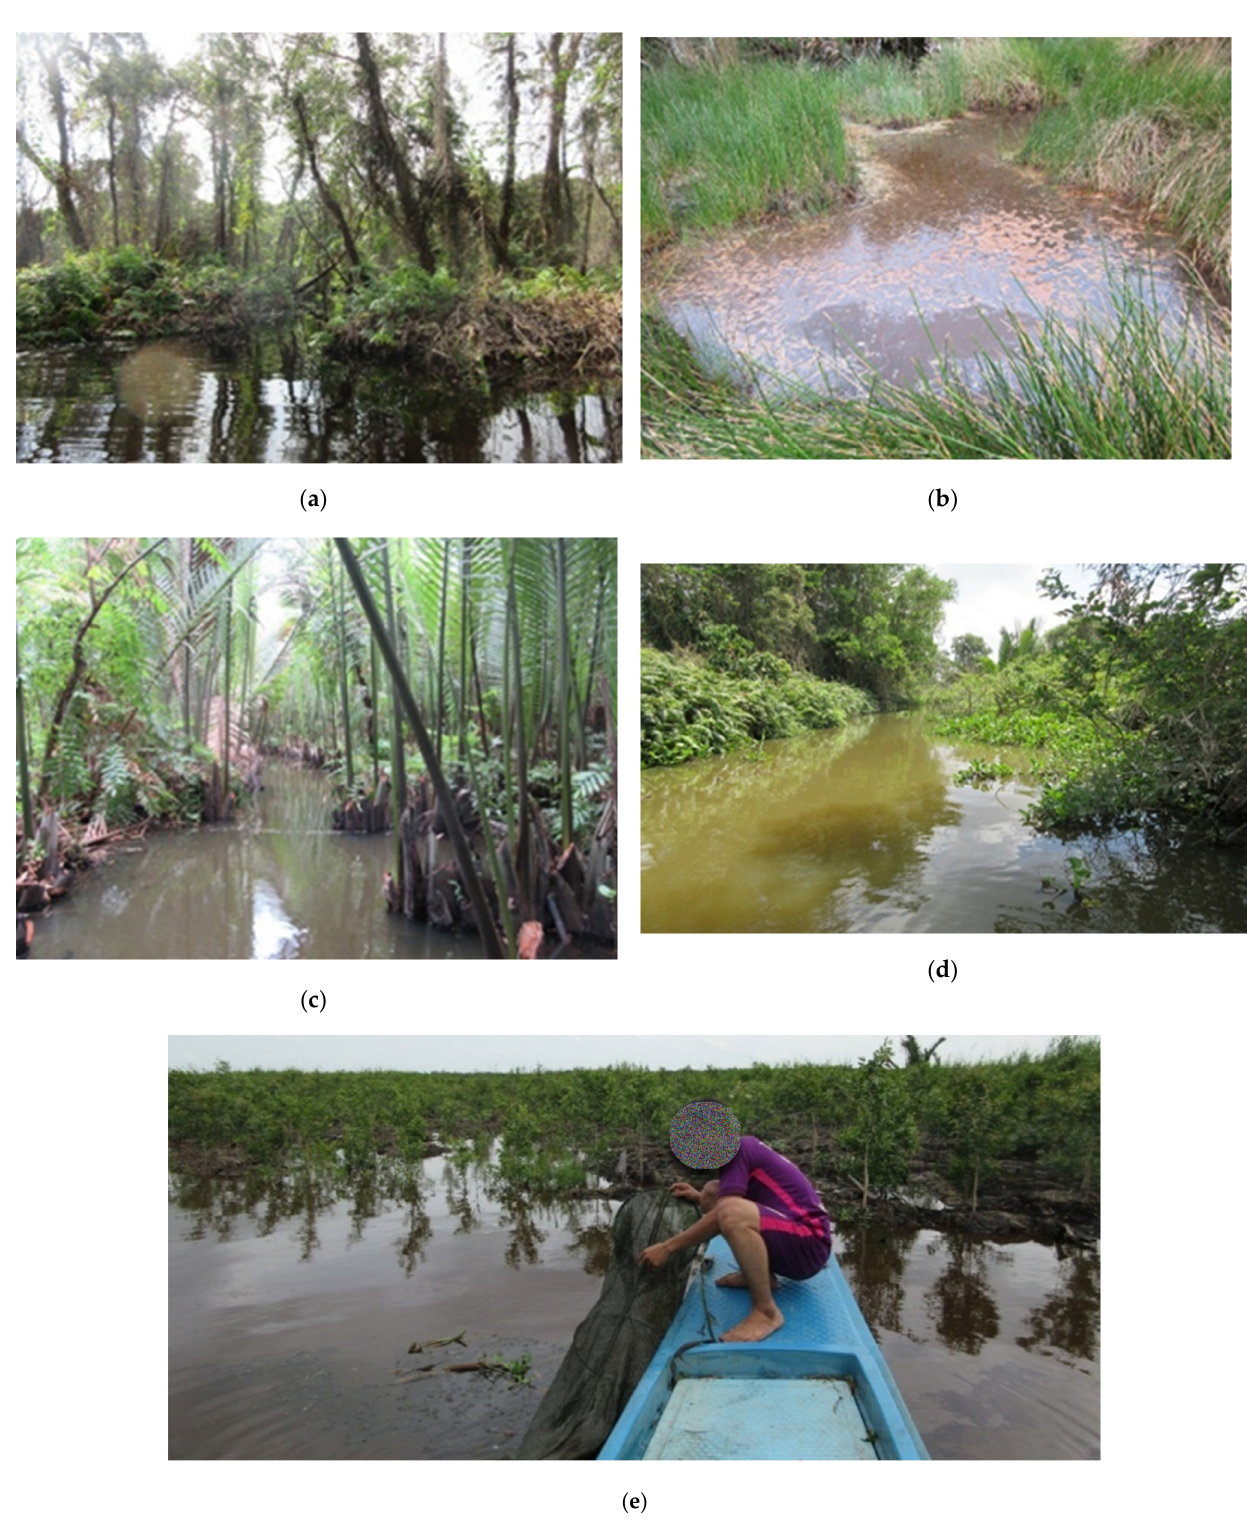
Figure 3. Location sampling at MPMF. ( a ) Melaleuca habitat, ( b ) wetland, ( c ) Nypa fruticans habitat, ( d ) canal habitat, ( e ) buffer zone. Table 1. Sample Location Specifications with Global Positioning System (GPS) coordinates. Seasonal samples were collected in 2016 and 2018.